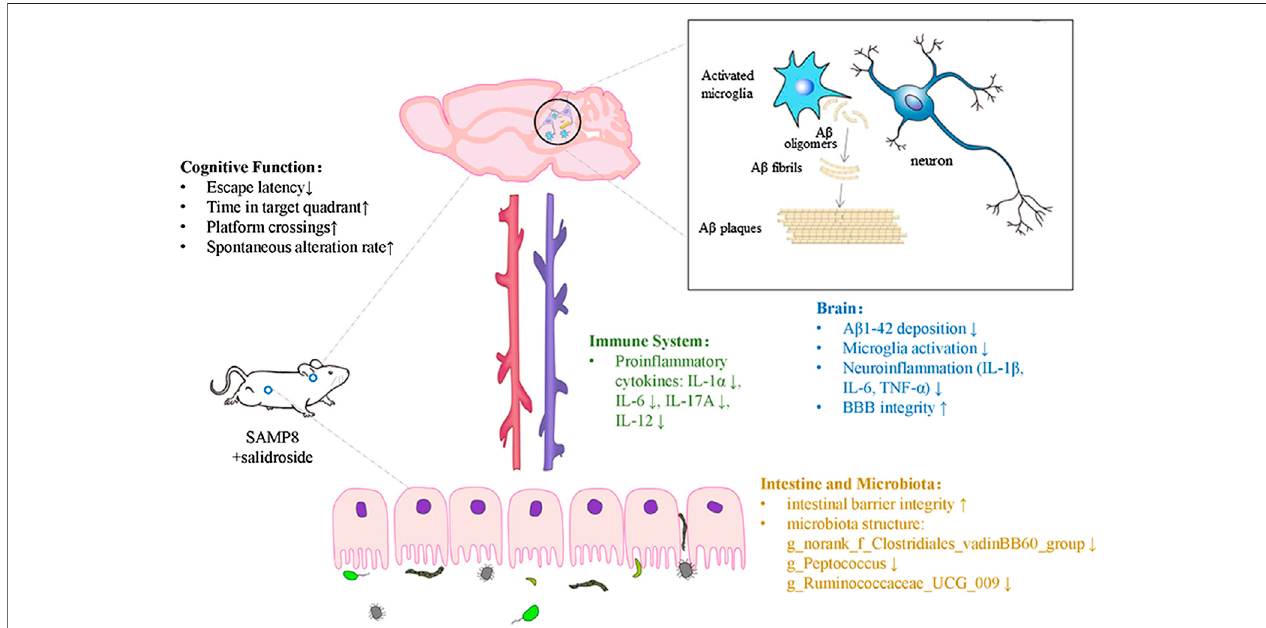
FIGURE 8 | Salidroside modulates the Gut-brain Axis in SAMP8